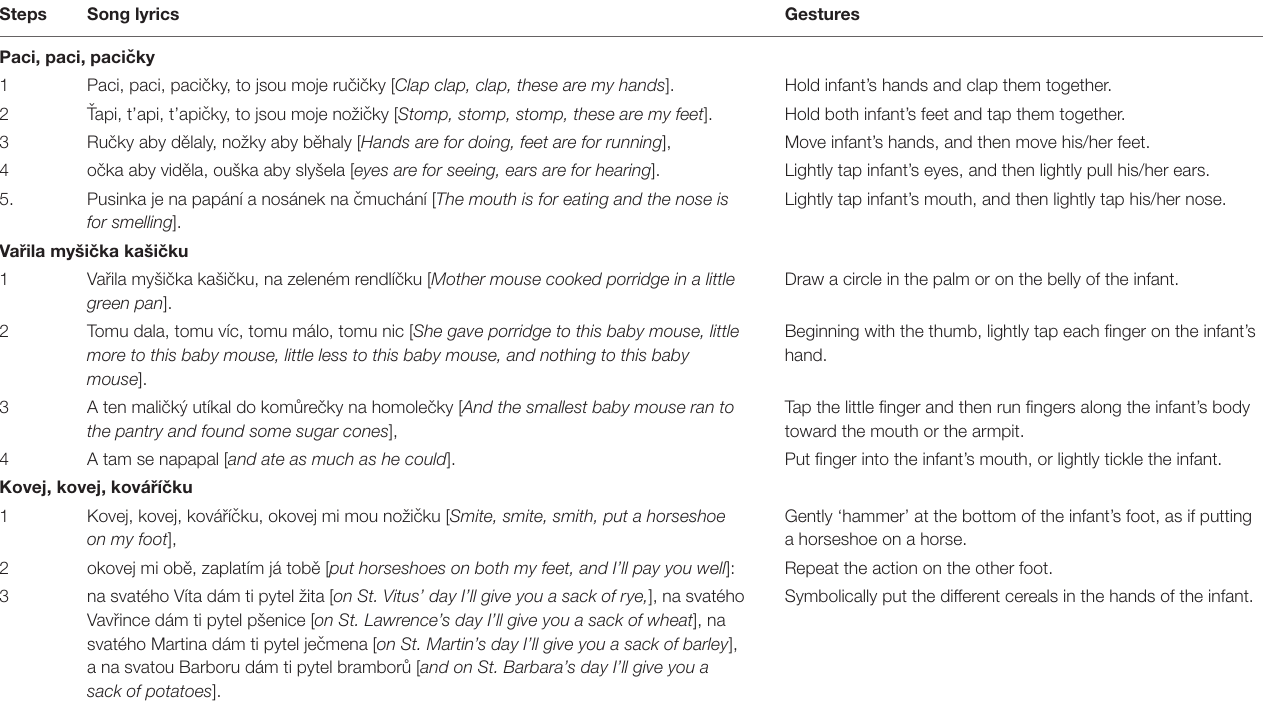
TABLE 1 | Multimodal sequence for the three most common social game routines in the present study. Steps